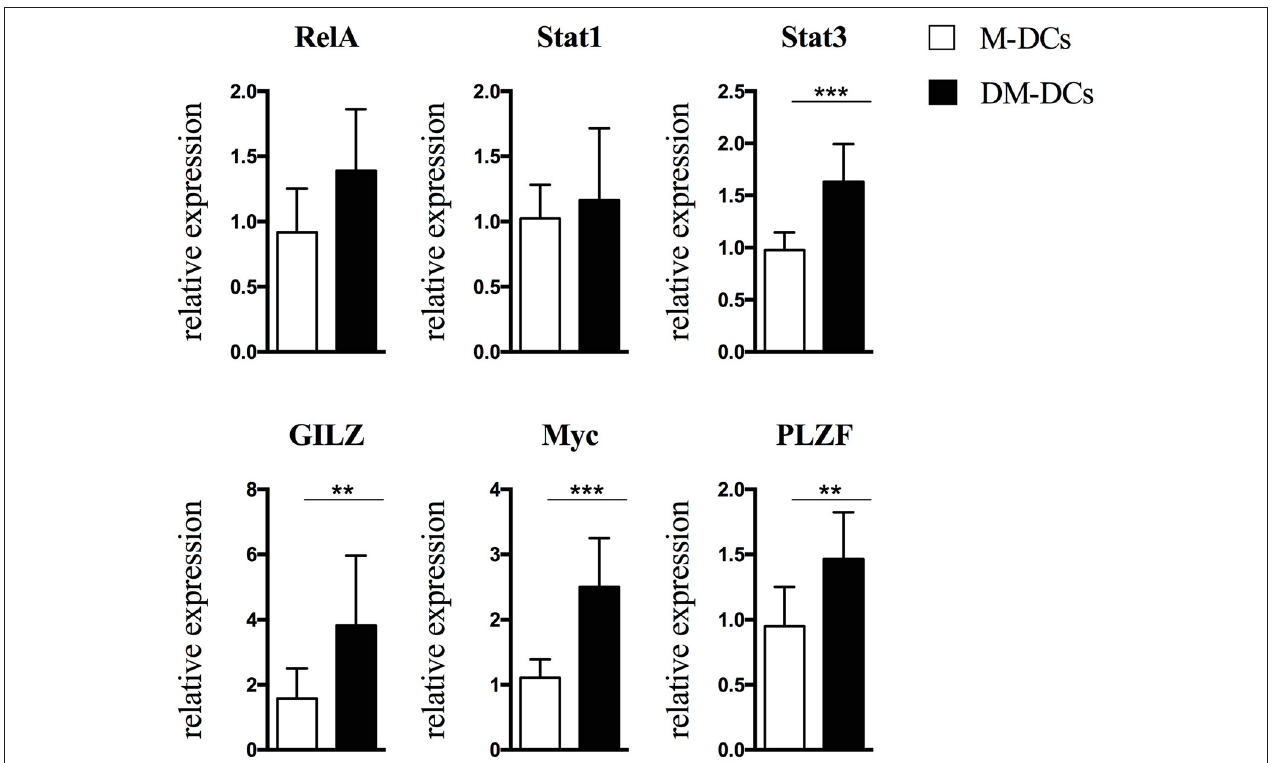
FIGURE 2 | Protein levels of transcription factors involved in regulation of Dex-modulated and MPLA-activated dendritic cells (DM-DCs) gene transcription correlate with gene expression. Protein level of transcription factors potentially involved in upstream regulation of gene expression of DM-DCs was determined by flow cytometry analysis. Shown are relative expression data of MFI values of M-DCs and DM-DCs respect to untreated DCs MFI values ( n = 10; ** p = 0.01; *** p =